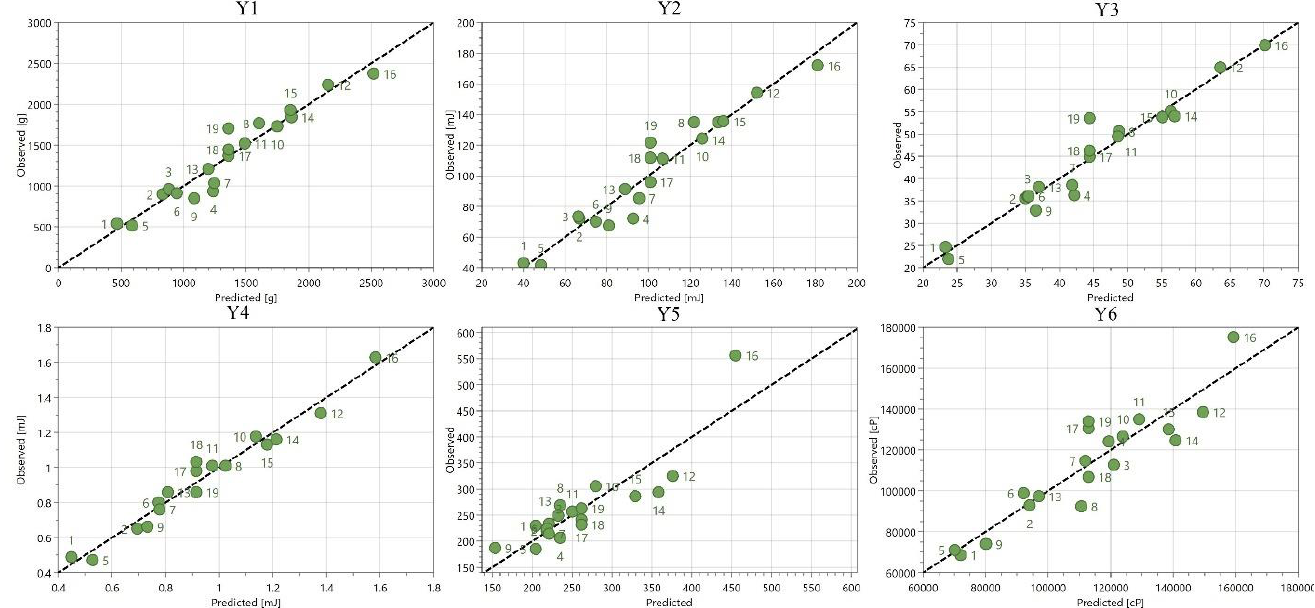
Figure 5. Residual curves of the observed responses as a function of the estimated responses (Y1, firmness; Y2, consistency; Y3, adhesiveness; Y4, stringiness; Y5, spreadability; Y6, viscosity). Table 5. Statistical parameters for ANOVA test and quality of fit.